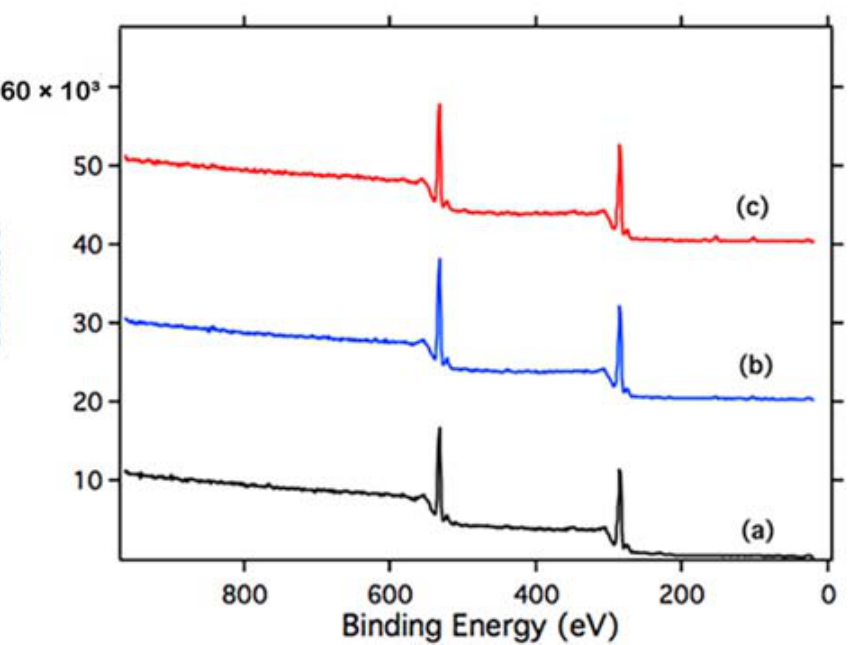
Figure 6. XPS survey scan spectra of surfaces (a) untreated PBS, (b) O 2 -plasma-treated for 30 s, and (c) O 2 -plasma-treated for 30 s and Ar post-crosslinking for 120 s.